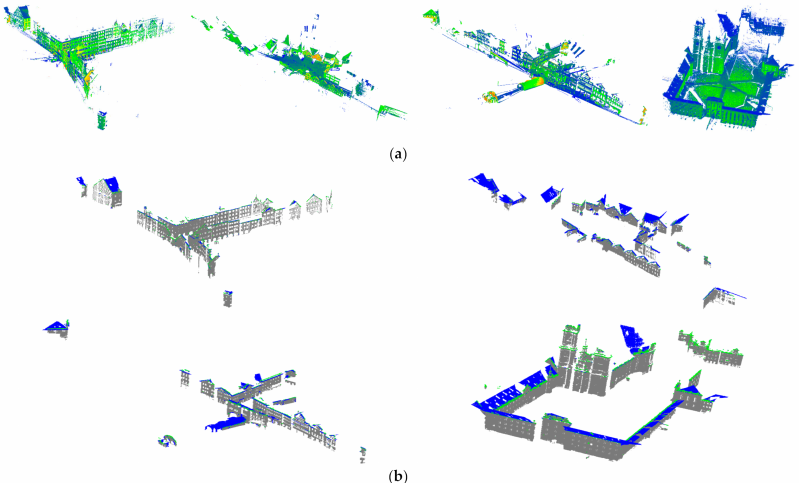
Figure 16. Extraction results of four selected scans in Semantic3D. ( a ) shows the original data for marketsquarefeldkirch7, sg27_10, sg27_8 and stgallencathedral1 colored by intensity. ( b ) shows corresponding extraction results (gray: facade points; blue: roof points; green: seed points on the top of each facade